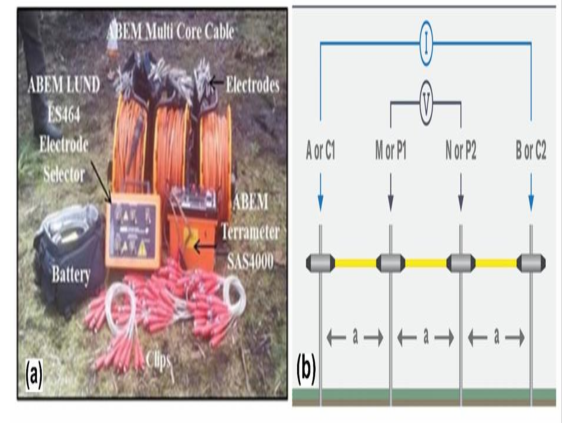
Fig. 2. (a) The ABEM Terrameter SAS4000 resistivity meter and ABEM LUND ES464 electrode selector system [34] ; (b) Wenner array [35,